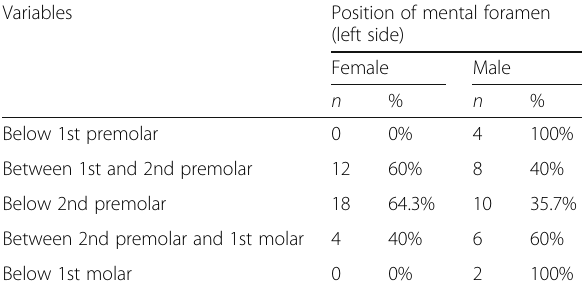
Table 1 Position of MF in relation to gender and adjacent teeth on the left side of mandible